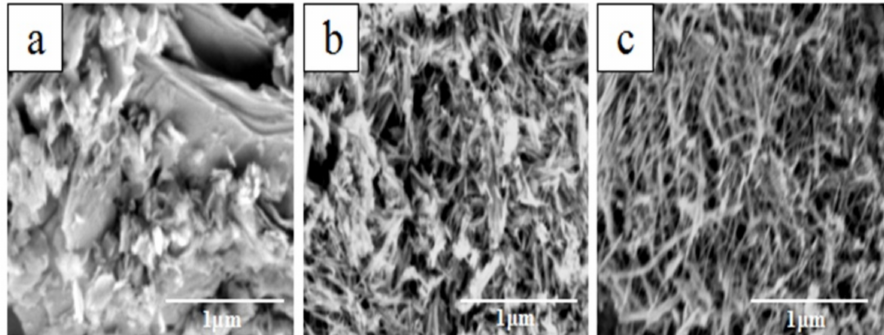
Figure 3. SEM images of the catalysts: ( a ) NT-purchased, ( b ) NT-P25, ( c ) NT-TBOT.